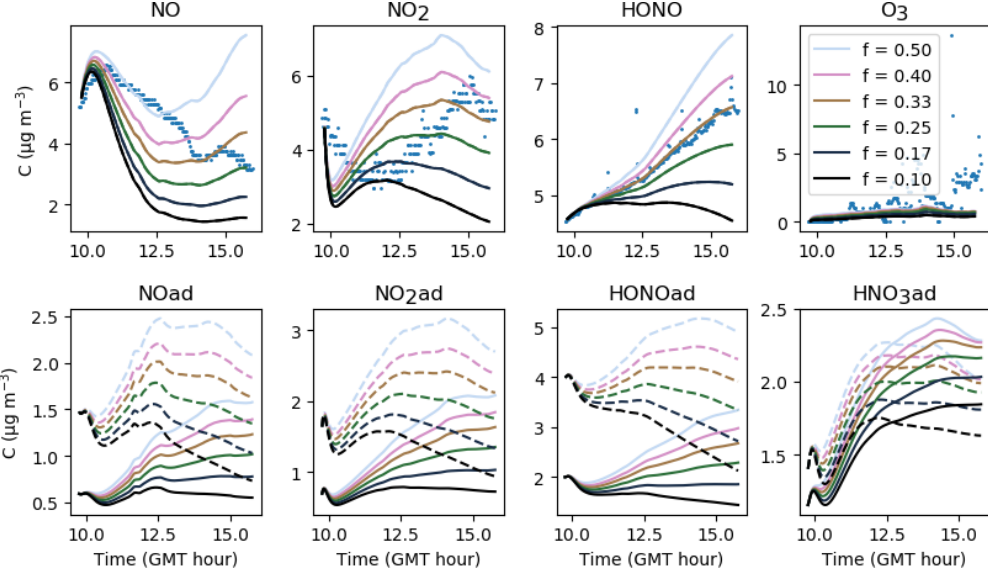
Figure 11. Gas-phase and adsorbed inorganic compounds simulated with different f . The blue dots denote the experimental measurements (Experiment 2). The solid lines represent the concentrations in the sunlit box and the dashed lines the concentrations in the shaded